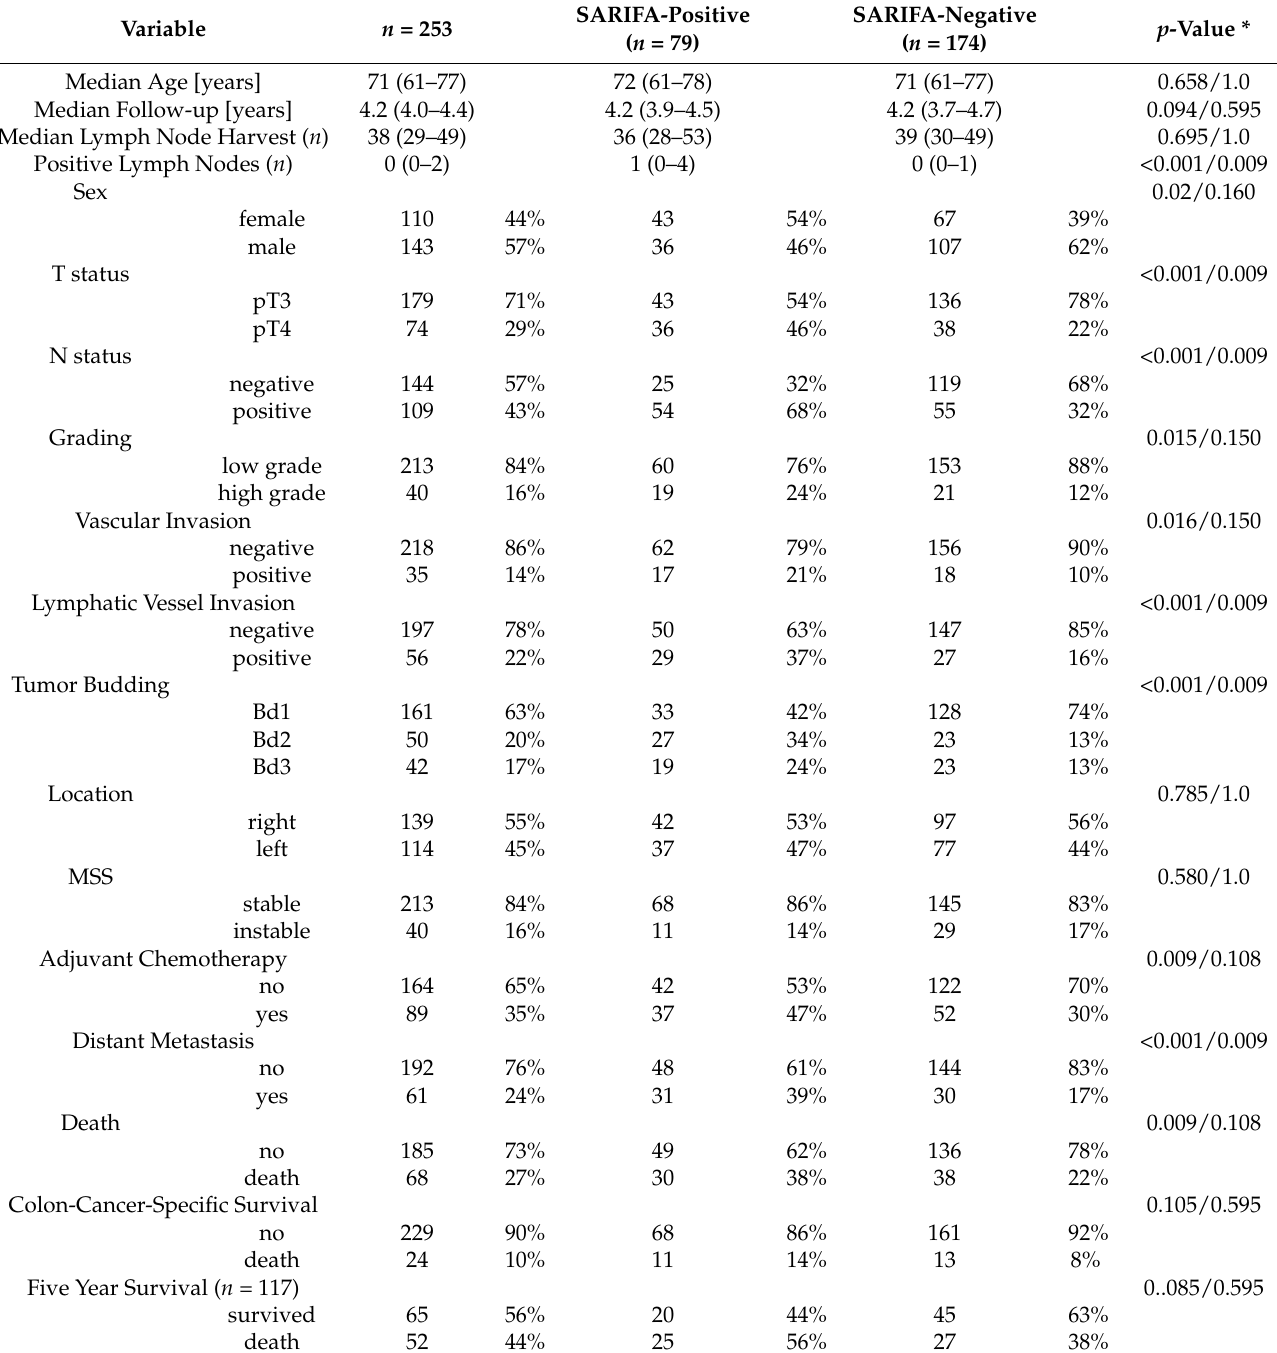
Table 2. Clinicopathological characteristics group